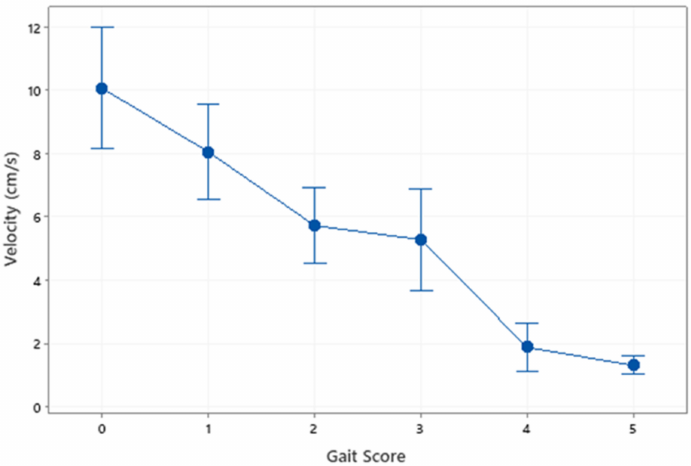
Figure 3. Confidence interval graph using the broiler walking velocity values of the unrest index and known gait scores.